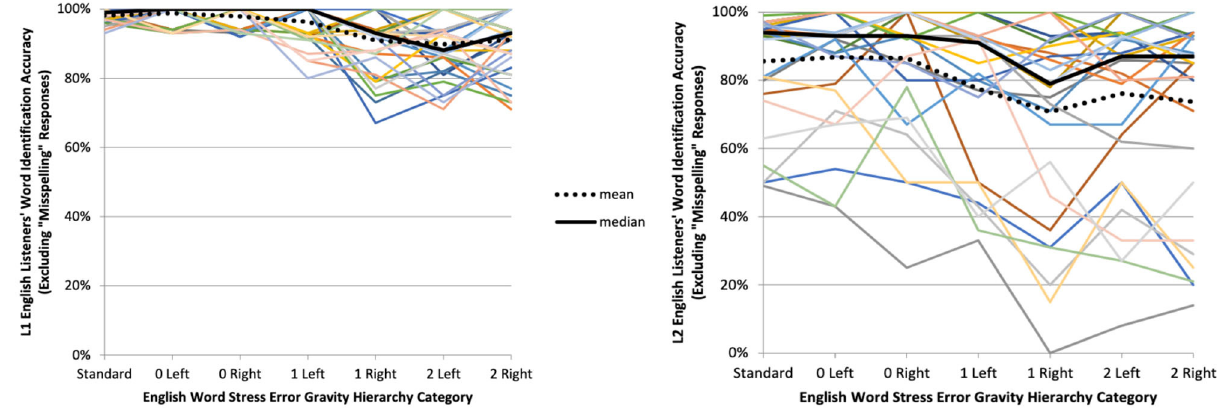
furthest from standard stress ( Figure 7 left).